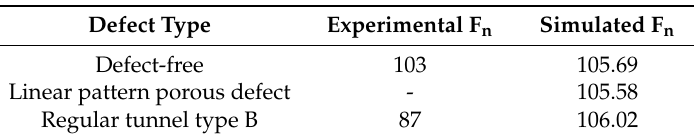
Table 6. Comparison between experimental and simulated frequency results.